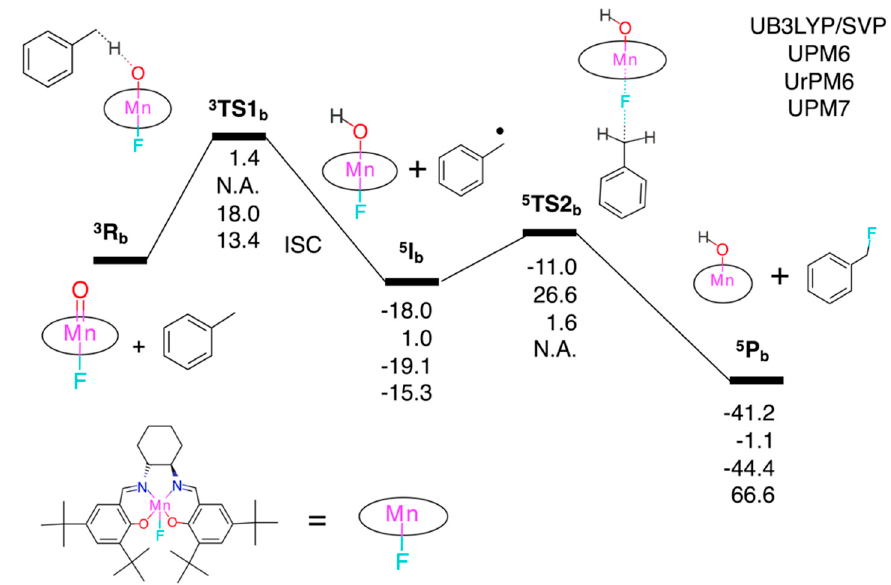
Figure 4. Potential energy profile with zero-point energy corrections (in kcal/mol) relative to the isolated 3 [F–Mn V =O(salen)] complex and toluene ( 3 R b ) obtained at the UB3LYP/SVP, UPM6, UrPM6, and UPM7 levels of theory. The superscripts 3 and 5 on the left side denote triplet and quintet spin states, N.A. represents not available (Geometry optimization failed), and ISC is the acronym of intersystem